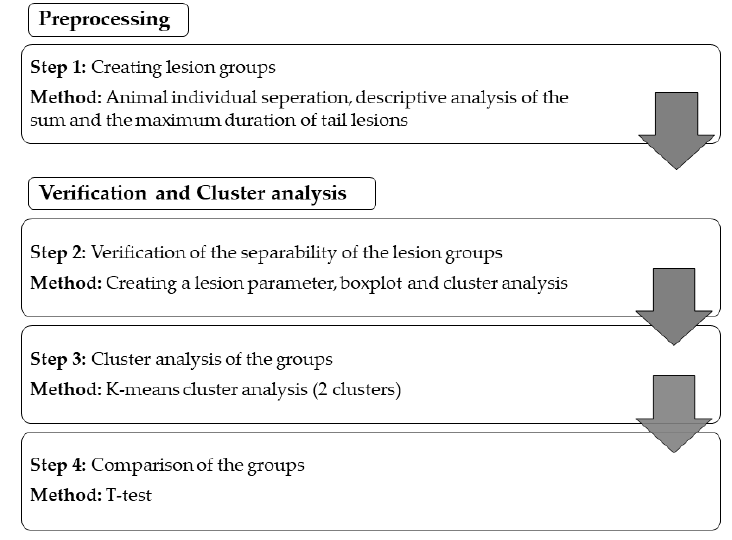
Figure 2. Workflow of the statistical analysis.